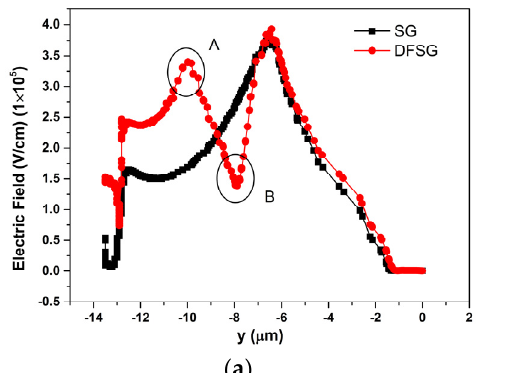
Figure 3. Electric field distributions comparing the ( a ) surface of the trench and ( b ) middle of the drift area for SGRSO and DFSGRSO UMOSFETs with the same n-drift area doping concentration.